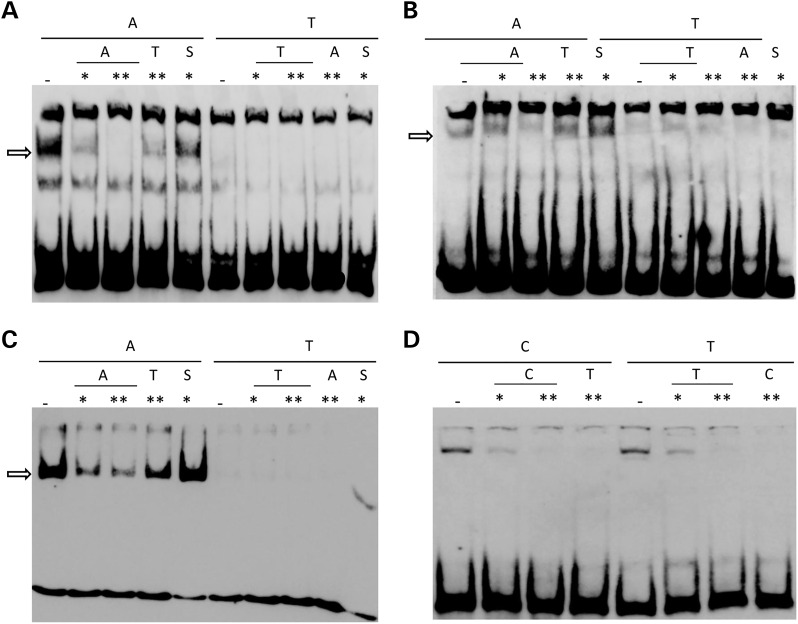
EMSA results. Probes centred on rs11855415 A and T alleles are incubated with nuclear extracts from (A) hNSC, (B) SH-SY5Y and (C) K562 cell lines. The arrow indicates a band appearing for allele A and absent for allele T, demonstrating DNA–protein binding. (D) No difference is observed between probes for rs7182874 C and T alleles when incubated with SH-SY5Y nuclear extracts. To test for specificity of the signal, different competitors where used as denoted for each lane: dash indicates no competitor; *(10-fold) and **(100-fold) indicate excess of cold competitor specified by the SNP alleles (specificity is shown by reduced signal for same allele as labelled probe while the opposite allele does not affect the binding); S is the scrambled competitor.